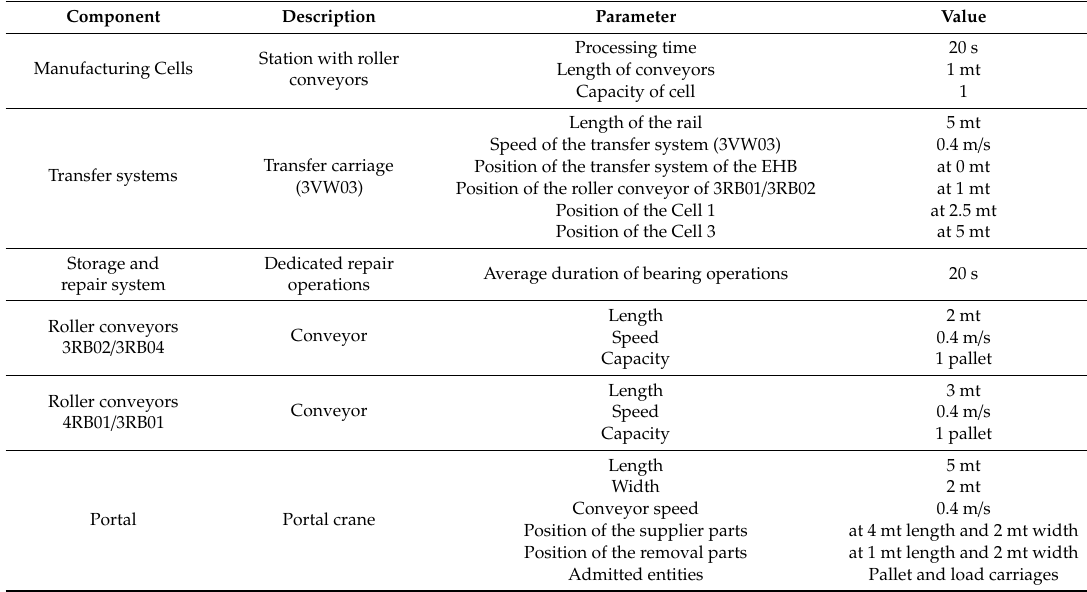
Table 3. Technical data of EDF simulation model [43,45]